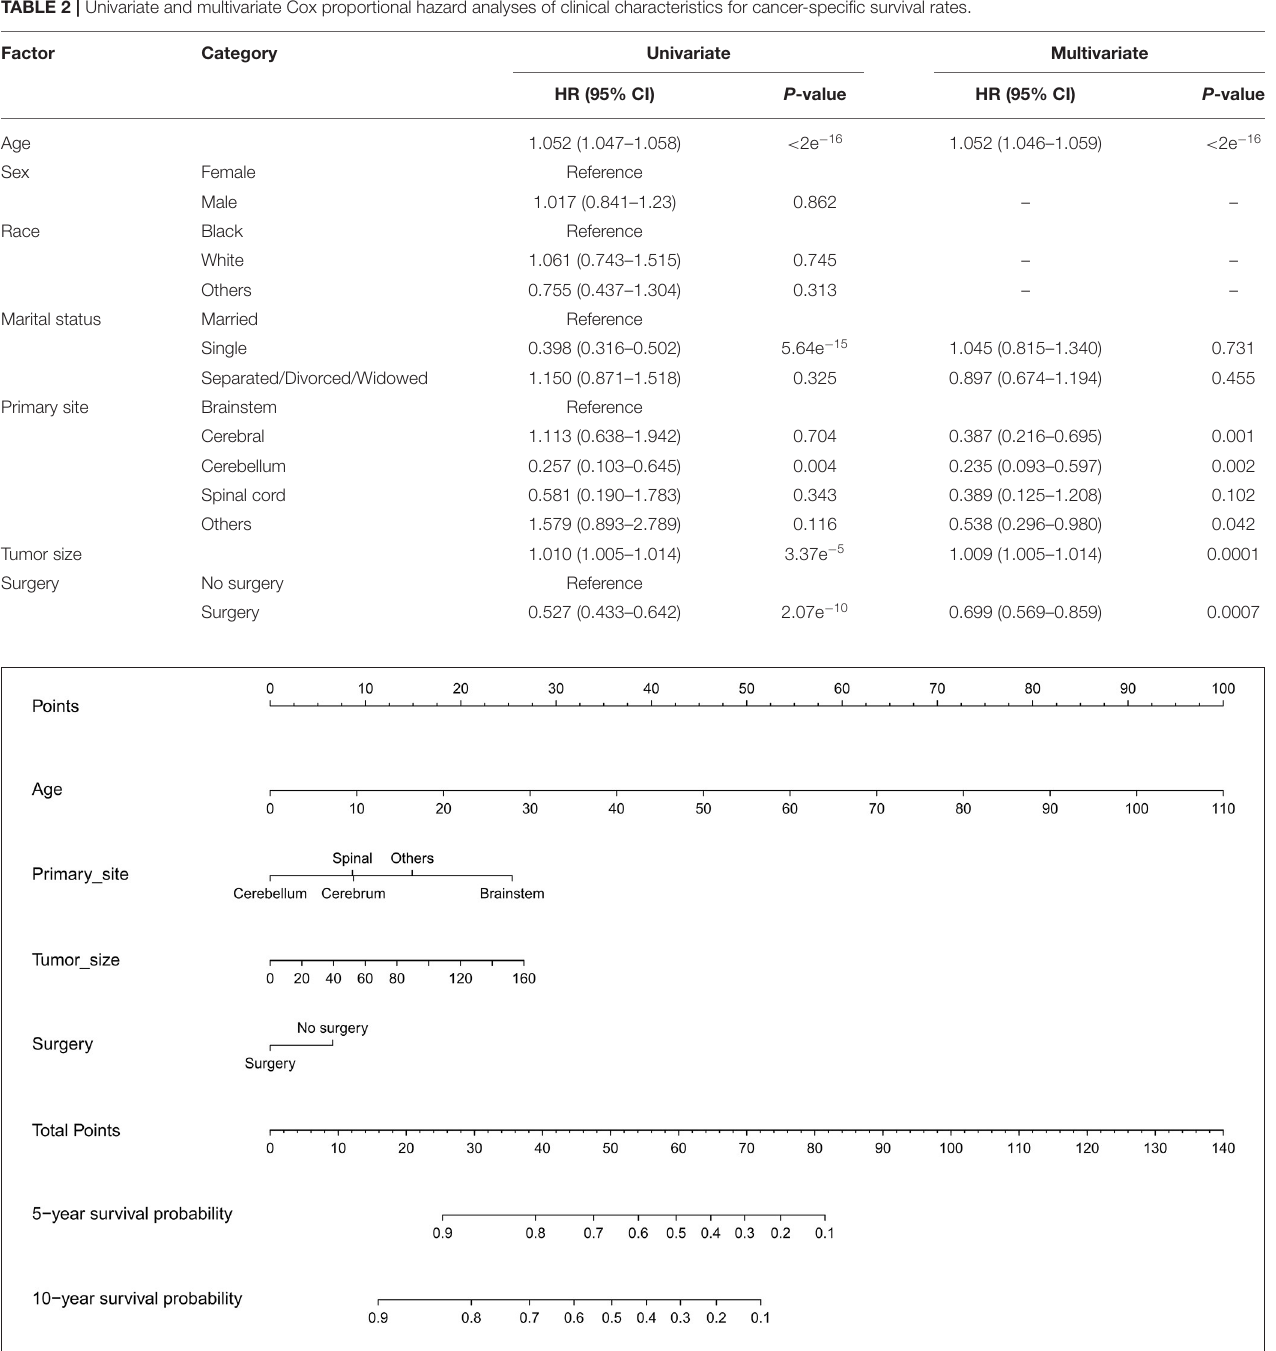
FIGURE 2 | Nomogram for predicting 5- and 10-year survival probability of diffuse astrocytoma.